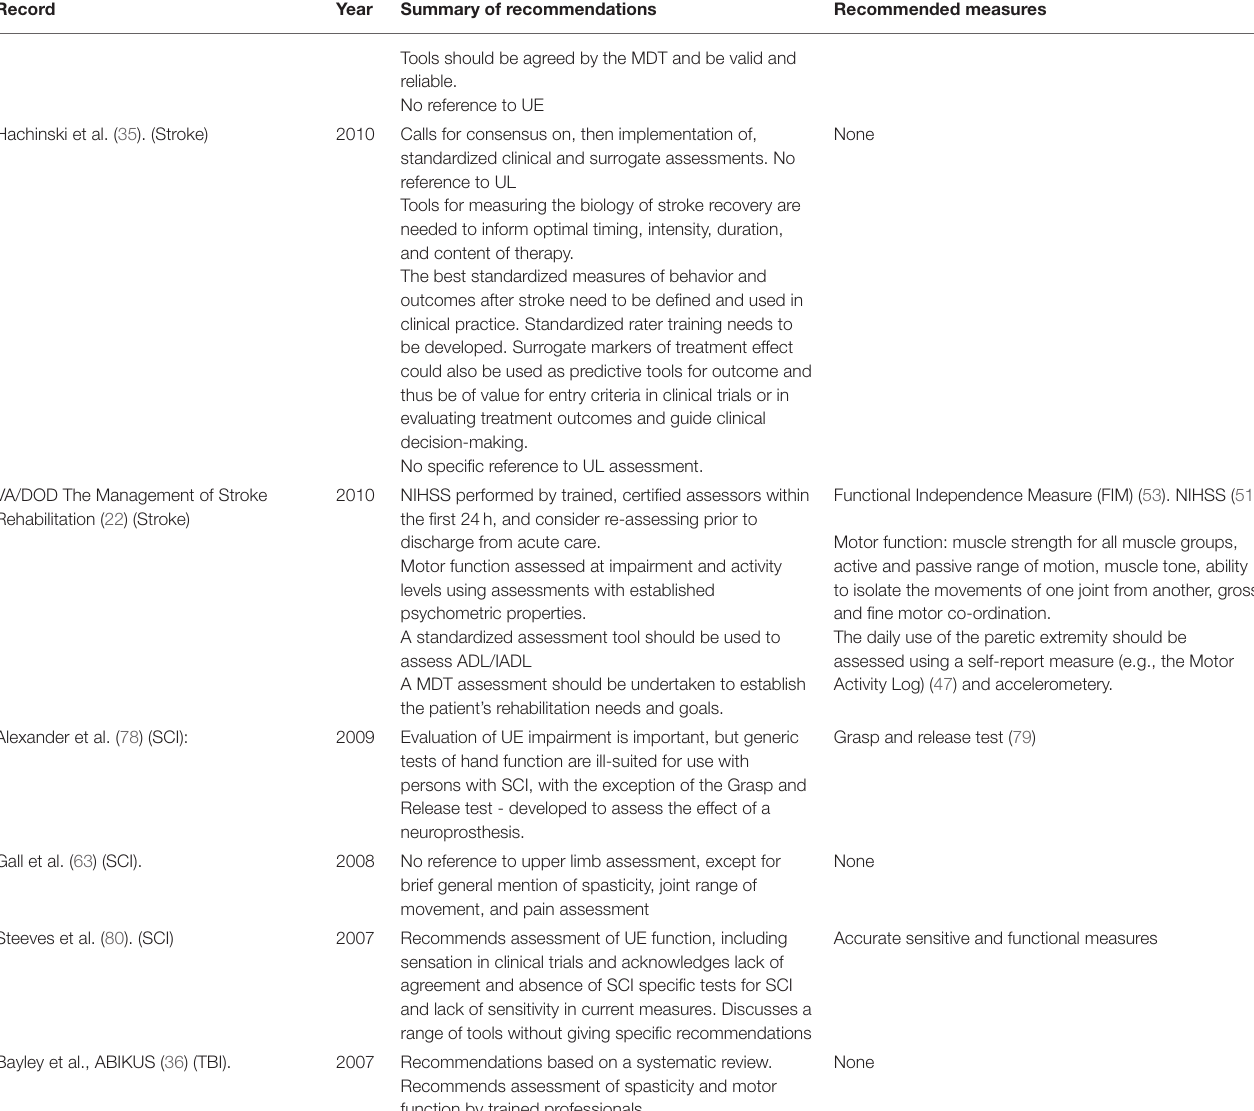
Motor function: muscle strength for all muscle groups, active and passive range of motion, muscle tone, ability to isolate the movements of one joint from another, gross and fine motor